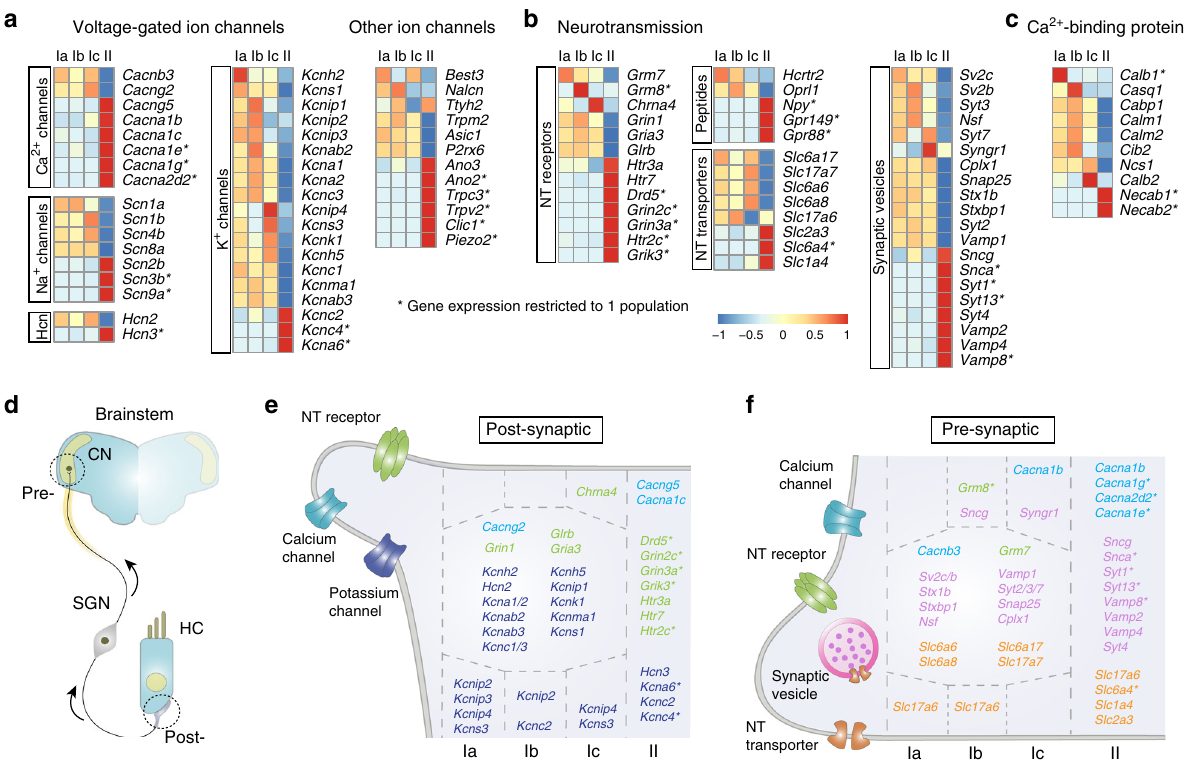
Fig. 3 Input – output communication transcriptional signature of SG neurons. a Differential expression of voltage-gated ion channels family among SG neurons. b , c Differential expression of neurotransmission systems including neurotransmitter (NT) receptors, peptides-related molecules, NT transporters, and synaptic vesicles ( b ) and of calcium-binding protein ( c ) among SG neurons (see also Supplementary Fig. 3). d Sketch of the SG neuron (SGN) synaptic connection with HC peripherally and with the cochlear nuclei (CN) in the brainstem. Arrows shows direction of the signal transmission. e , f Schematic representation of the transcriptional portrait of the post-synaptic ( e ) and pre-synaptic ( f ) sites of SG neuron types, based on differentially expressed gene shown in a ,